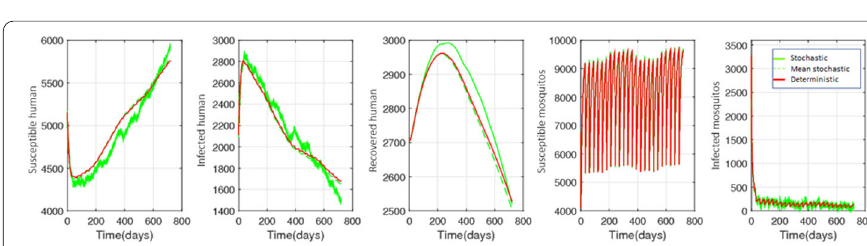
Figure 8 Model simulation with periodic fumigations and without bed nets with the influence of the